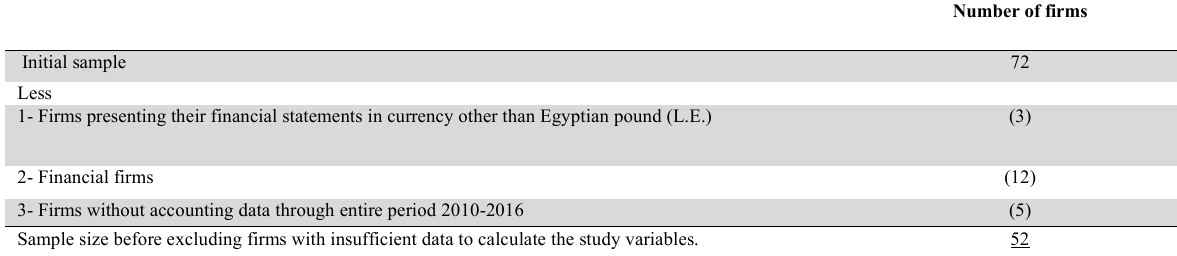
Initial sample of the study for listed Egyptian firms that were included in the EGX 30 Index over the period from 2003 to 2009